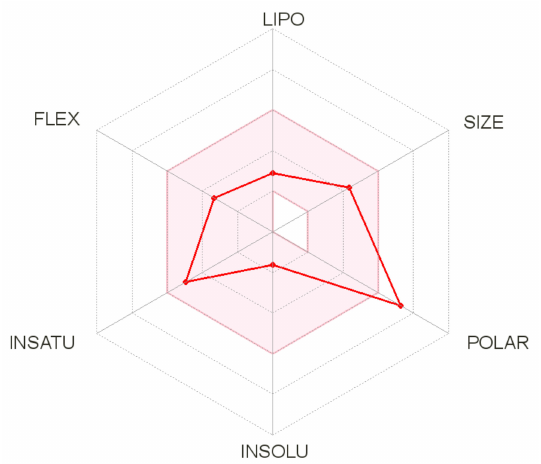
Figure 7. The bioavailability radar plot of cryptochlorogenic acid. The pink area represents the optimal range for each property (lipophilicity: XLOGP3 between − 0.7 and +5.0, size: MW between 150 and 500g/mol, polarity: TPSA between 20 and 130Å2, solubility: log S not higher than 6, saturation: fraction of carbons in the sp3 hybridization not less than 0.25, and flexibility: no more than 9 rotatable bonds). Cryptochlorogenic acid is predicted not to be orally bioavailable because it is too